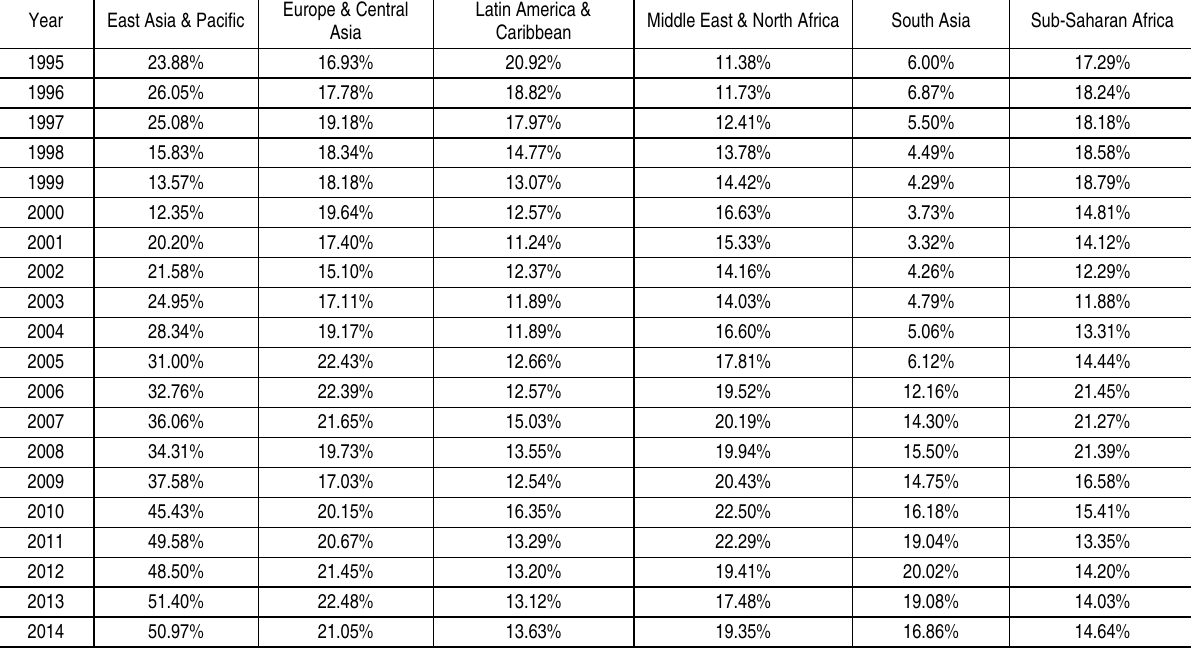
Table 3. Trends in ST external debt as a percentage of total gross external debt region-wise